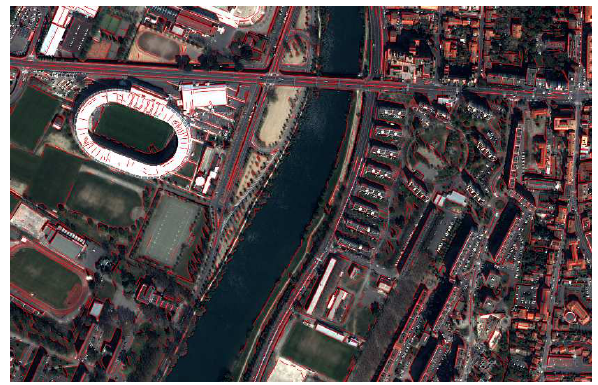
Figure 4. Example of Orfeo ToolBox algorithm results: Pan- sharpening and Line segment Detection on a Quickbird image of Toulouse,